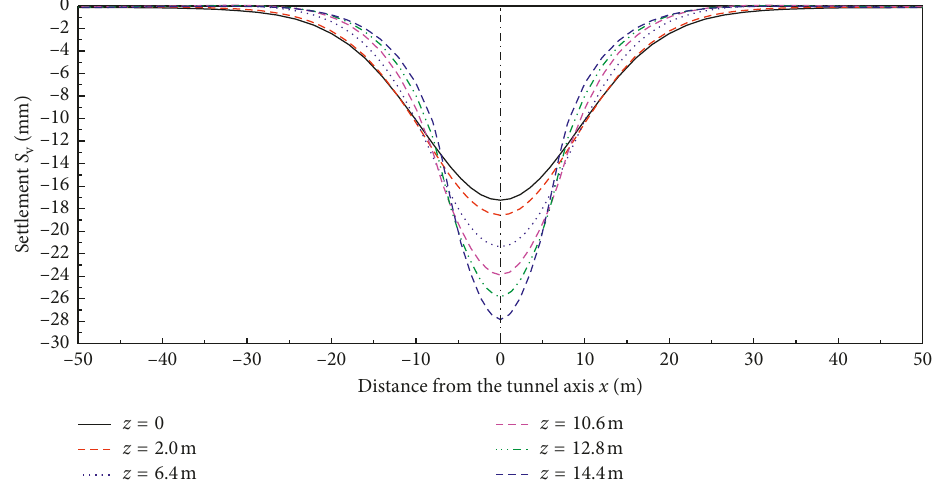
Figure 14: Vertical displacements in the transverse section of different